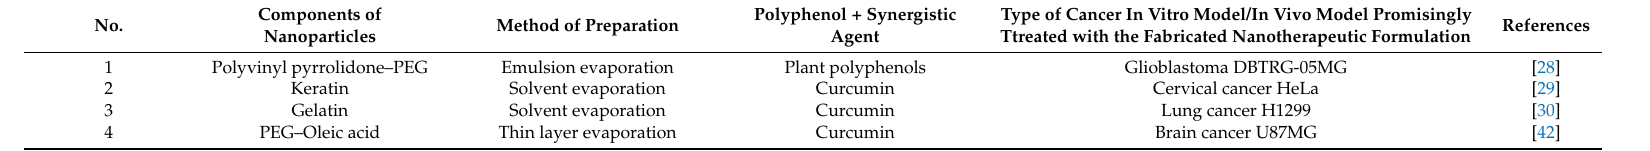
Table 1. Polyphenol-loaded polymersomes for the treatment of cancer.